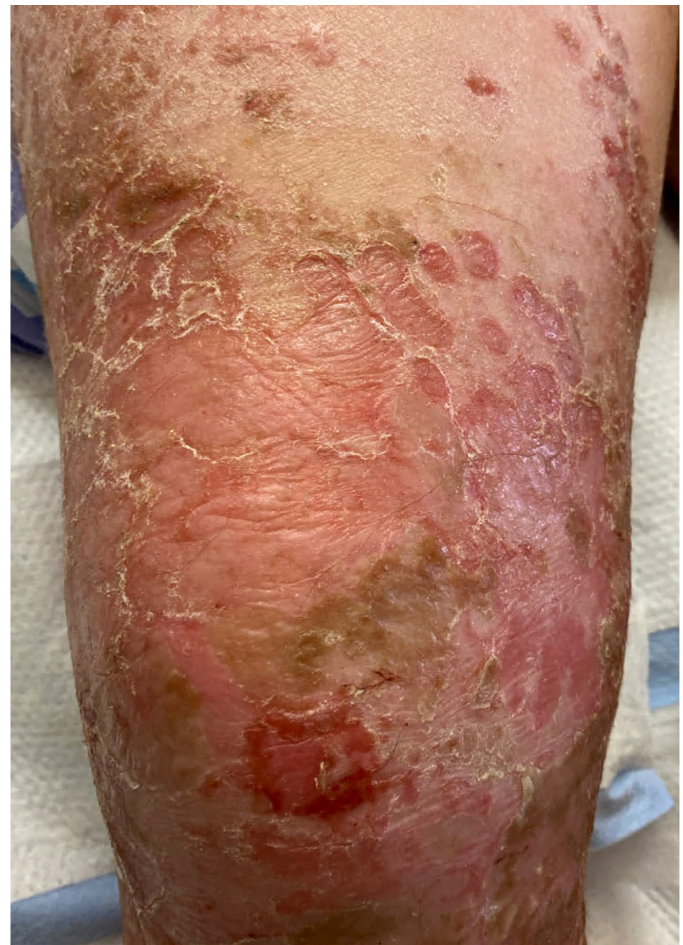
Figure 3. Bullous impetigo. After bullae rupture, superficial erosions and surrounding collarettes of scale remain, along with a thin brown crust. Original image provided by Kiran Motaparthi, MD.